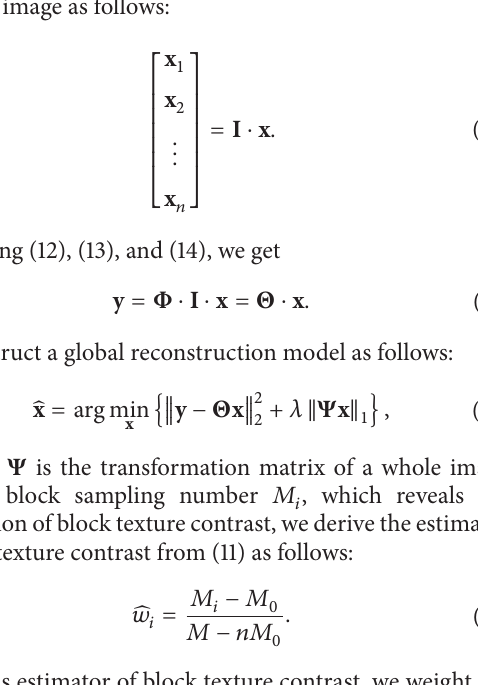
the only adjustable parameter. Figure 4 shows the impact of different 𝛼 value on the PSNR value when sample rate 𝑆 is 0.1, 0.3, and 0.5, respectively. It can be seen that each test image has higher PSNR values with S being 0.3 or 0.5 and 𝛼 ranging from 0.1 to 0.3, which indicates that our method significantly improves the reconstruction quality at a moderate 𝛼 value. However, when 𝑆 is set to be 0.1, higher PSNR value appears with 𝛼 being near 0.55, and the PSNR value lightly reduces with 𝛼 increasing from 0.55, which indicates that 𝛼 should be greater at a low sampling rate. 𝛼 is, the more feature points gather in the rich-texture